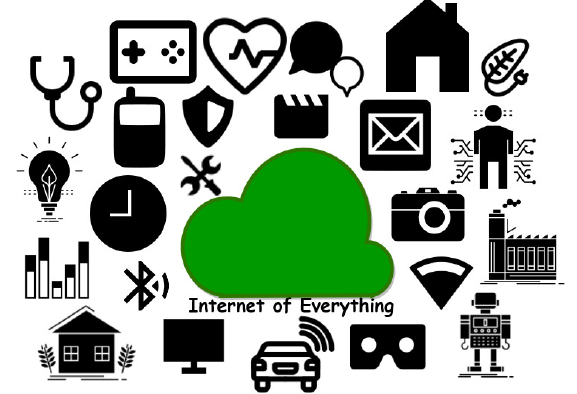
Figure 1. Internet of